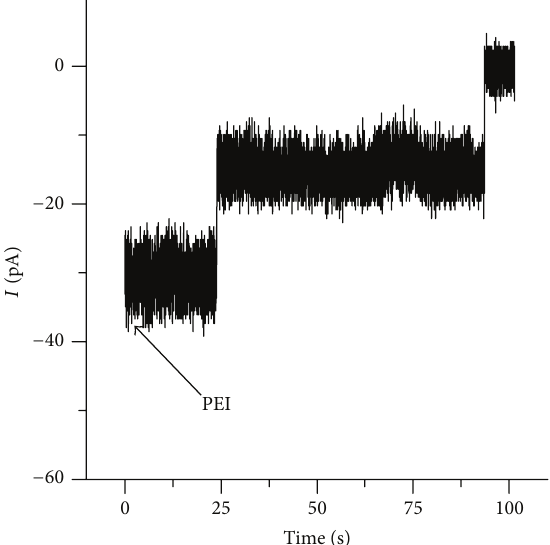
Figure 5: Addition of PEI (10 𝜇 M final concentration) to the trans side of an Aso-based BLM containing two lysenin channels induces a step-wise and unitary decrease in the open current and indicates quick and individual interactions of PEI with each of the two inserted